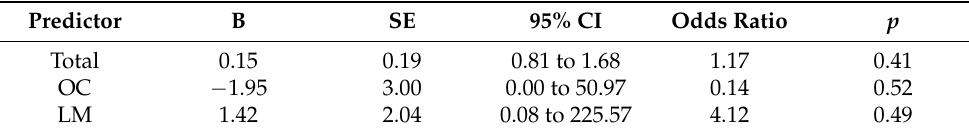
Table 5. Logistic regression of Baseline FMS competency predicting the likelihood of being over- weight/obese at Follow-Up. Predictor B SE 95% CI Odds Ratio p Total 0.15 0.19 0.81 to 1.68 1.17 0.41 OC − 1.95 3.00 0.00 to 50.97 0.14 0.52